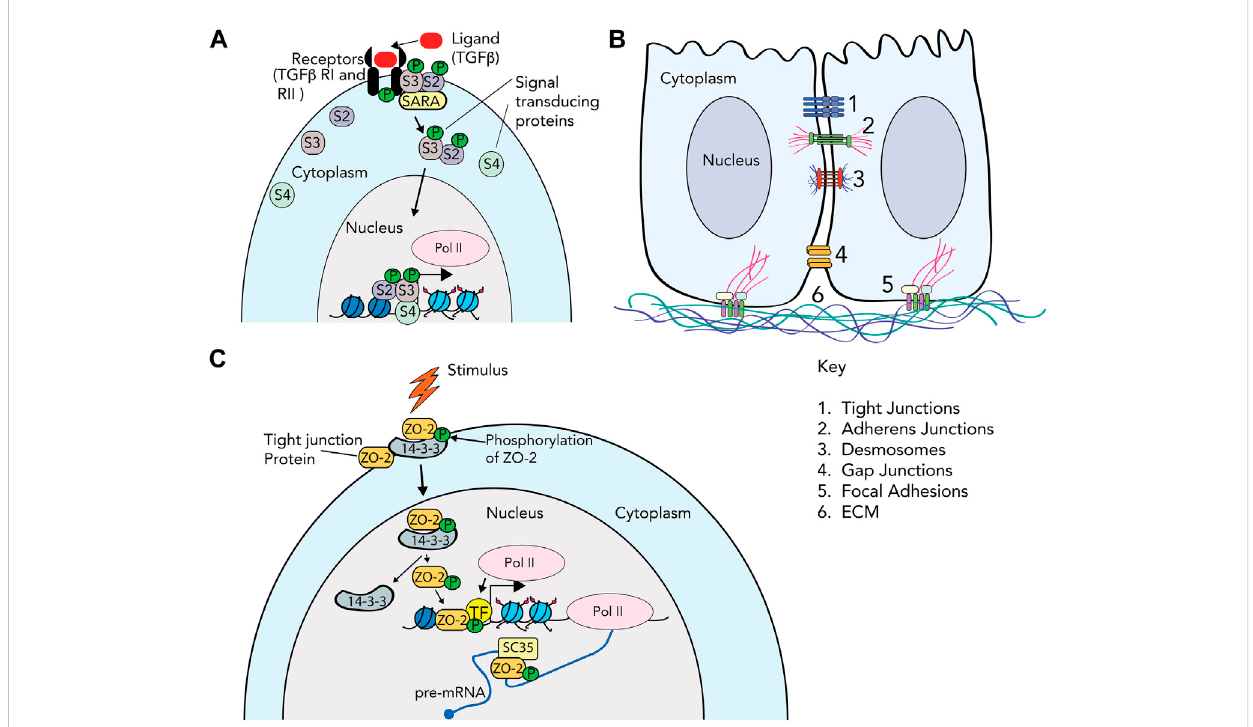
FIGURE 1 Cell attachment and cytoskeletal protein complexes. (A) TGF- β signaling as an example of the classical signaling cascade . The TGF- β ligand is recognized by speci fi creceptors(TGF- β RII) on thecell membrane, which inducesphosphorylation of TGF- β RI. Once TGF- β RIis activated, thebinding of R-SMAD (receptor SMAD) proteins to the receptor is mediated by SARA (the SMAD anchor for receptor activation). The R-SMAD proteins (Smad2/S2 and Smad3/S3inthisexample)arephosphorylated,andassociatewithco-Smad(Smad4/S4).TheSmadproteinsthentransducethesignaltothenucleus by associating with chromatin, and activating or repressing gene expression. (B) Cell junctions . The cartoon depicts 2 cells, with cytoplasm and nucleus, and the multiple protein complexes that comprise (1) tight junctions; (2) adherens junctions; (3) desmosomes; (4) gap junctions; (5) focal adhesions; and (6) extracellular matrix. (C) Signal transduction directly through cell adhesion proteins. In this example, the ZO-2 protein in tight junctions is phosphorylated by SRPK1, and subsequently bound by the 14-3-3 protein and enters the nucleus. Inside the nucleus, ZO-2 interacts with transcription factors(TF)suchasTEADorSAF-btoaltergenetranscription.ItalsoassociateswithsplicingproteinSC-35toregulatesplicing.Otherrolesforvariouscell adhesion proteins that enter the nucleus such as telomere maintenance, splicing and chromatin structure are discussed in the